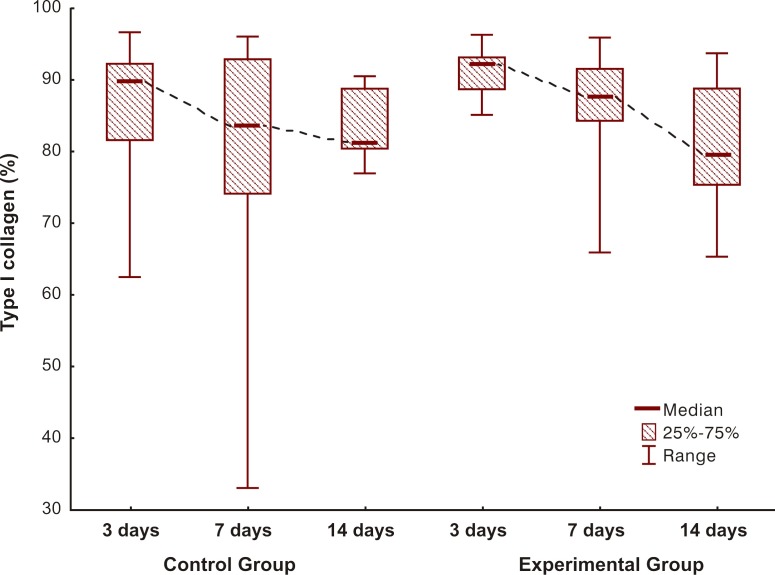
Comparison of groups for mature collagen.